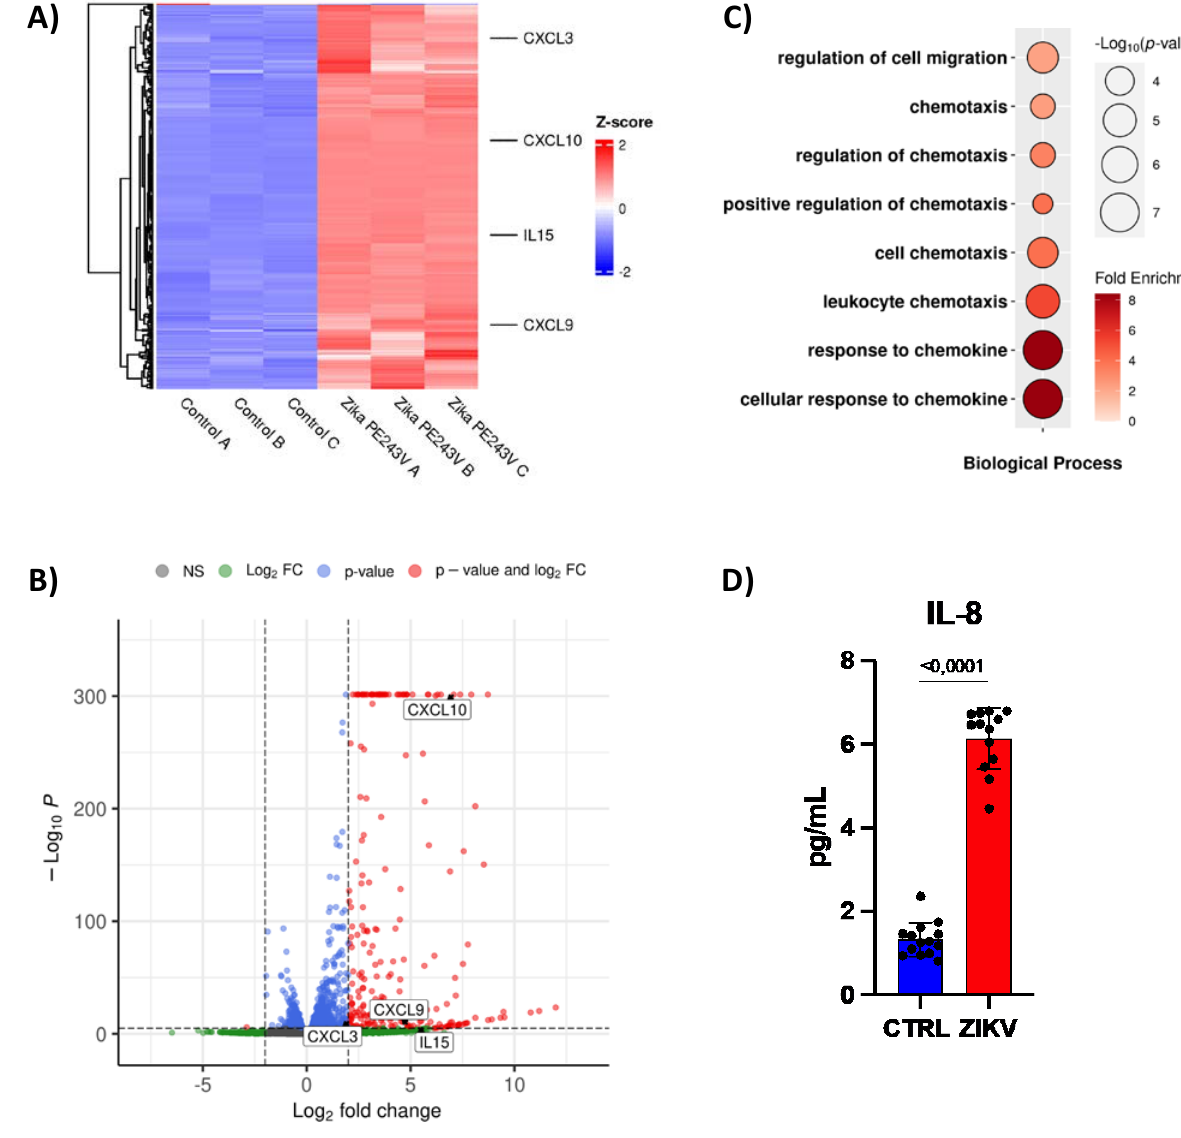
Figure 4. ZIKV downregulates miRNAs to recruit immune cells. ( A ) Heat-map, ( B ) Bubble plot of gene ontology, and ( C ) volcano plot of public RNA-sequencing from hiNPCs (n = 3). 31,040 variables. ( D ) Quantification of IL − 8 by CBA in supernatant of CTRL or ZIKV infected human NPCs after 48 h post infection (n = 12). Graphs represent three independent experiments. Unpaired t